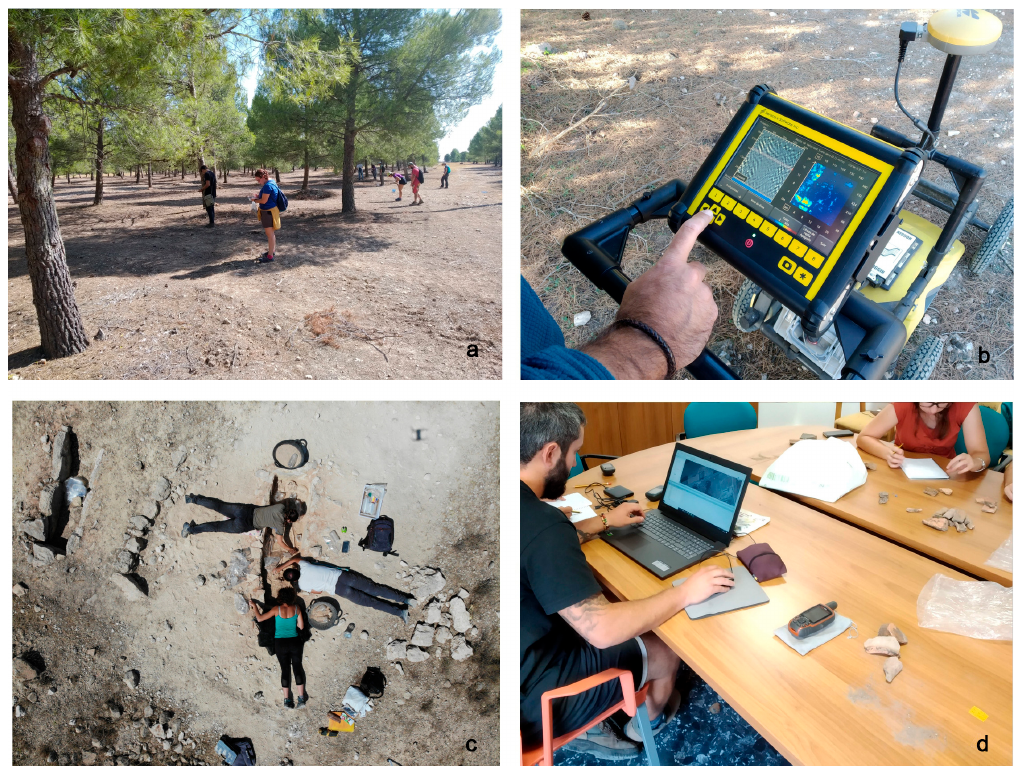
Figure 2. Images of the different phases of research: ( a ) surface prospecting; ( b ) geophysical prospecting using GPR; ( c ) archaeological excavation; ( d ) data processing in GIS.